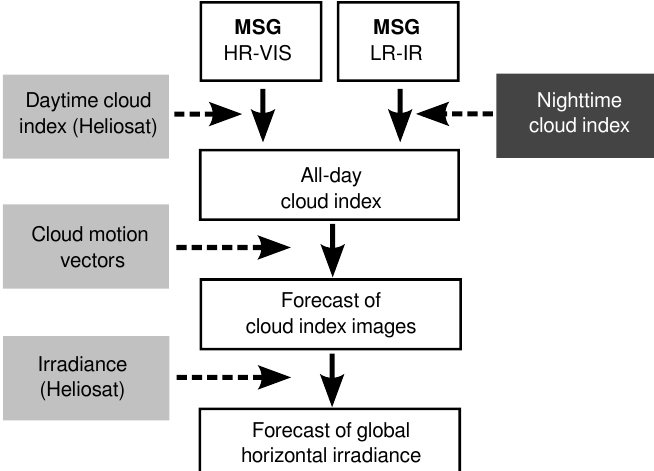
Figure 9. Retrieval of global horizontal irradiance forecasts using the cloud motion vector (CMV) approach based on cloud index images gathered from MSG HR-VIS by the Heliosat method and from IR channels by the BTD ∗